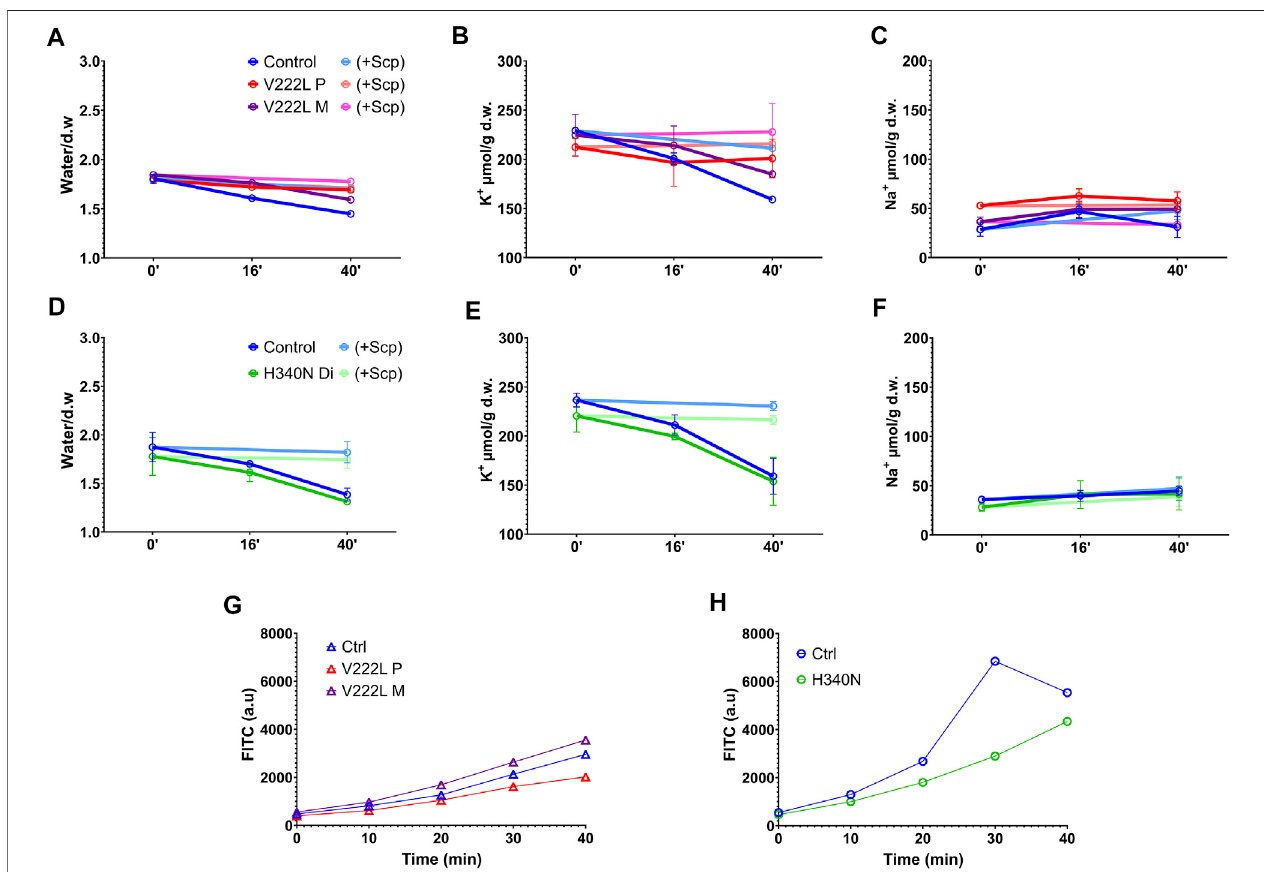
FIGURE 3 | RBC ion, water, and Ca 2+ contents in response to vanadate. Washed RBCs were submitted to 5 mM Vanadate with or without 4 µM Senicapoc treatment in the presence of 0.5 mM ouabain. Water, K +, and Na + contents were measured at different time points (0 ′ , 16 ′ and 40 ′ ). Water content (A,D) , K + content (B,E) , and Na + content (C,F) are represented for control in blue, V222L proband A in red and proband A ’ s mother in purple: panel (A,B,C) , and control in blue, H340N proband B in green: panel (D,E,F) . Bright colors represented Senicapoc effect compared to untreated conditions. Data are given as mean ± SD of triplicate experiments done on either a single blood shipment for proband A [panel (A,B,C) ] or two different blood shipments for proband B [panel (D,E,F) ]. (G,H) : Fresh RBCs were washed in Ringer without calcium and incubated with 5 µM Fluo-4AM 30min at 37 ° C. Fluo-4AM-loaded RBCs were then incubated in Ringer solution with 1 mM Ca 2+ and5 mMvanadate.FluorescencewasmeasuredwithaFACSasafunctionoftime.DataaregivenasFITCinarbitraryunits,medianofasingleexperiment,10,000 events. The fl uorescence linked to basalintracellular Ca 2+ concentration wasinarbitrary units, mean ±s.e.m.: 750± 9forproband A, 1,167± 6forproband A ’ s mother, and 839 ± 6 for control and 528 ± 5 for proband B compared to 533 ± 7 for control.